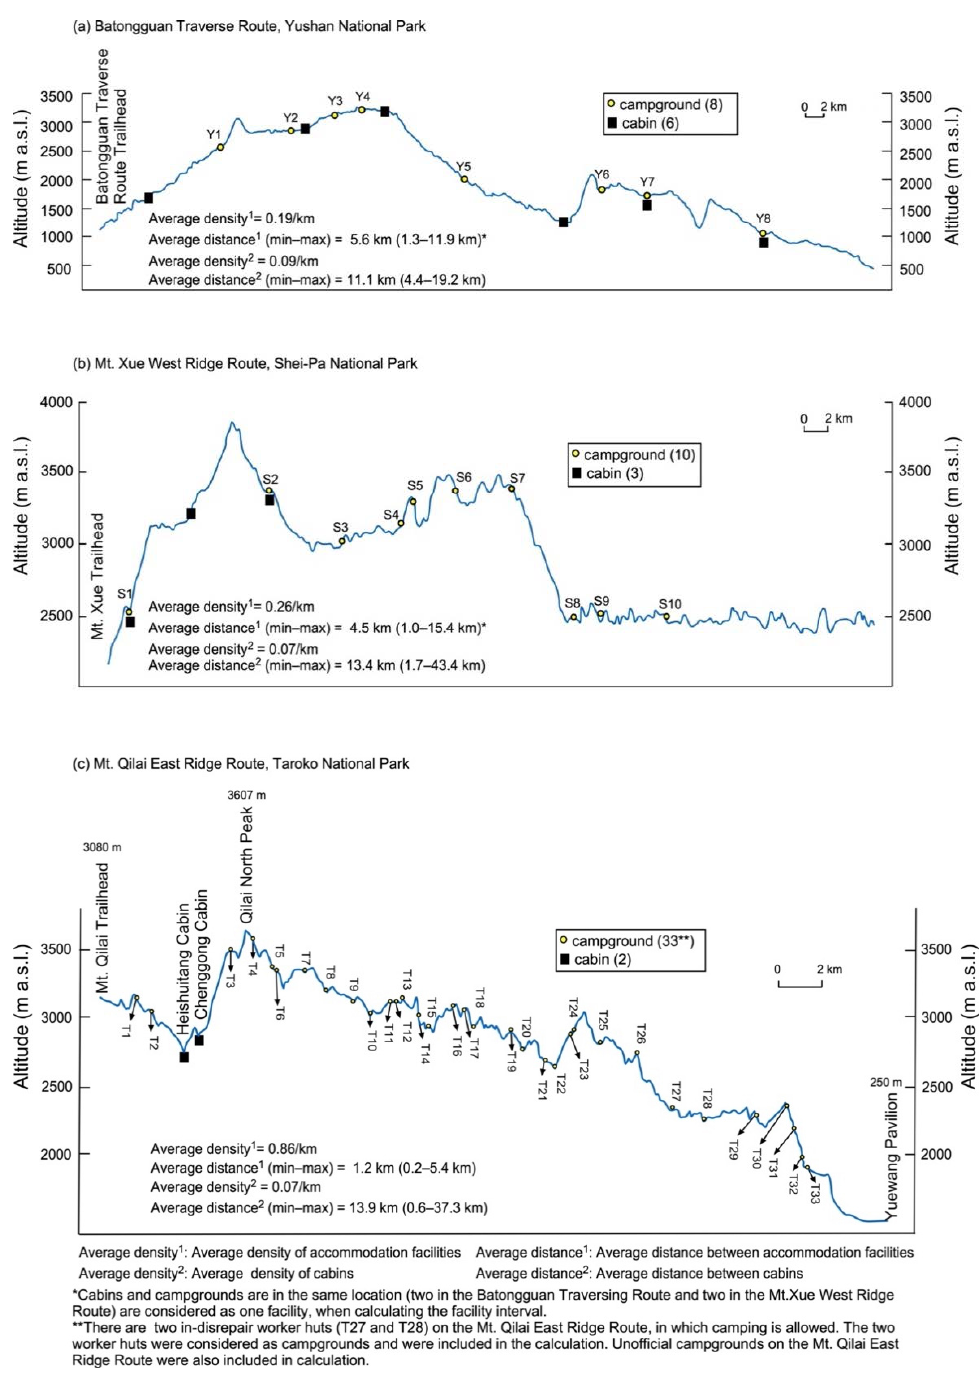
Figure 8. Density and spacing of accommodation facilities (campgrounds and cabins) along the selected trail sections in the three national parks. Campgrounds with a name label below the ridgeline are informal and not reservable. ( a ) compiled from the official route profile of Yushan National Park; ( b ) created using 25 m DEM exported from the WorldElevation/Terrain provided in ArcMap 10.8.1; ( c ) compiled from the map of “Taroko Mountain Range 1:25,000” published by Sunriver Culture Co.